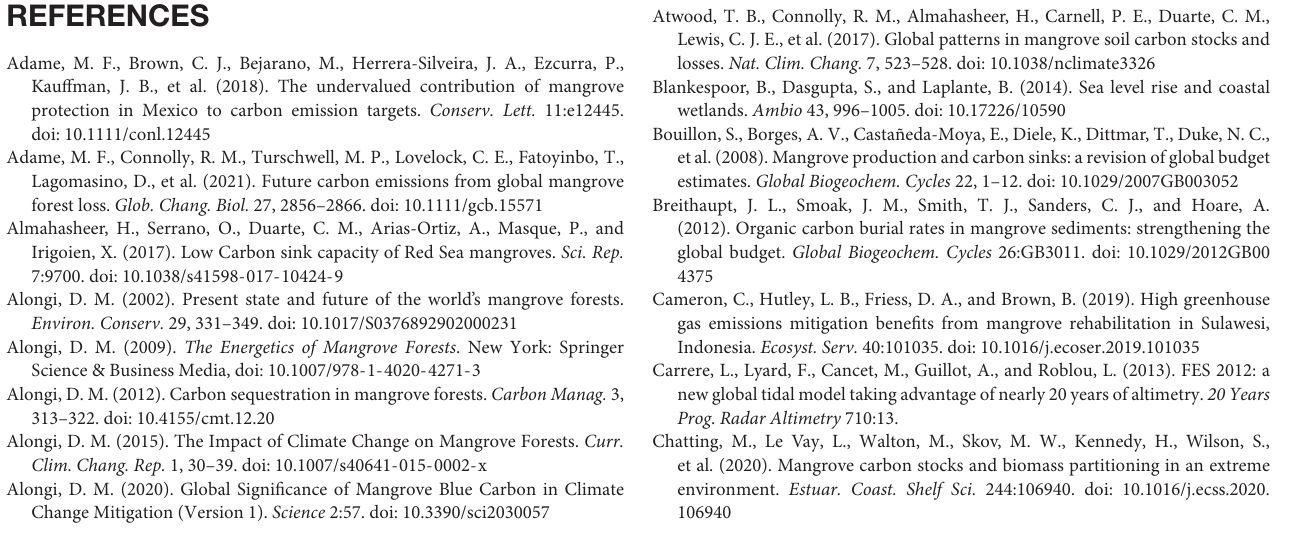
Supplementary Data Sheet 1 | Secondary literature data of soil carbon used in modeling analysis. Supplementary Data Sheet 2 | Secondary literature data of soil sequestration rates used in modeling